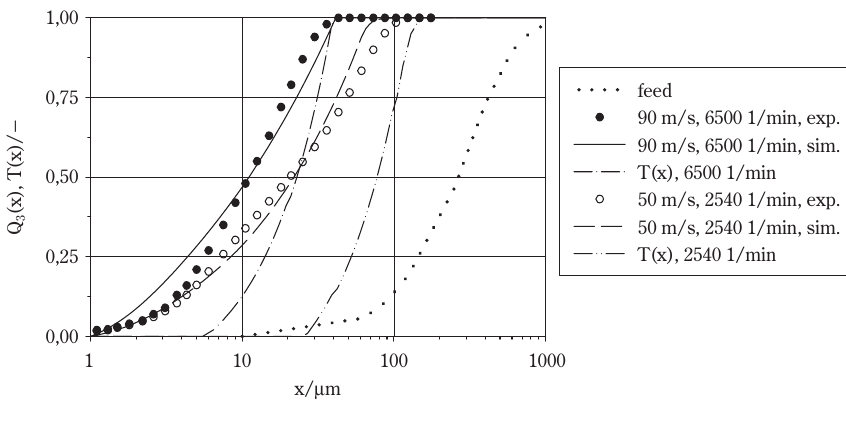
Fig. 8 Representative simulation results for the air classifier mill